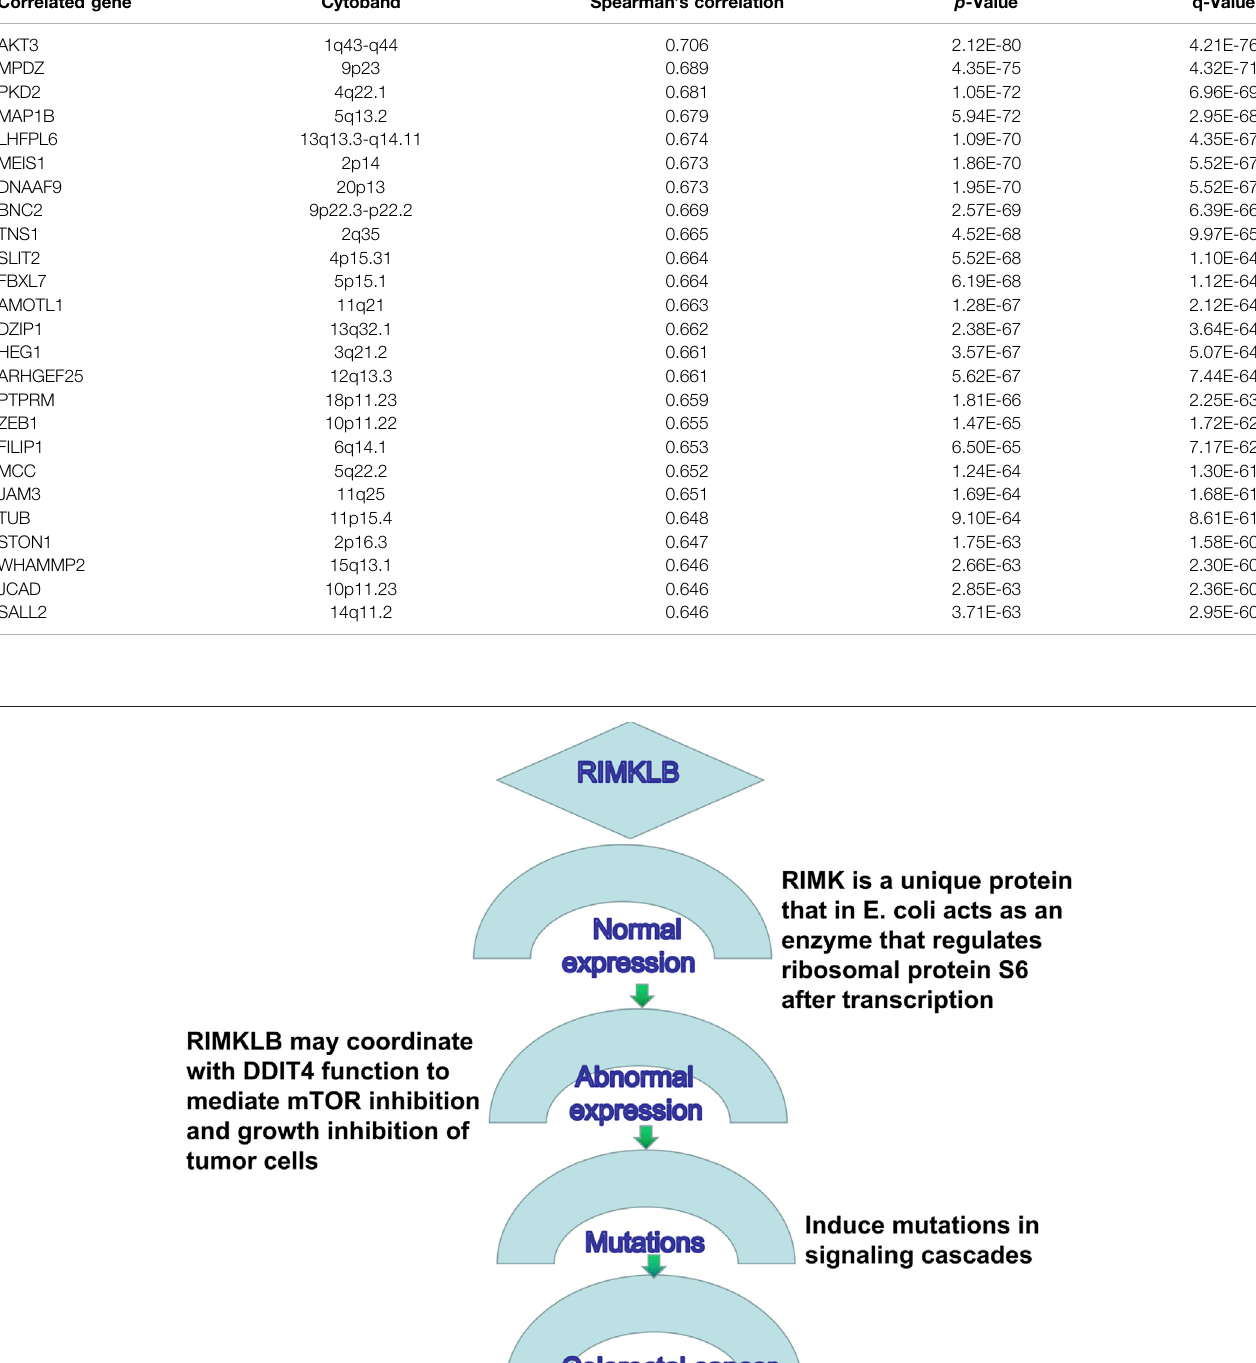
Frontiers in Genetics |